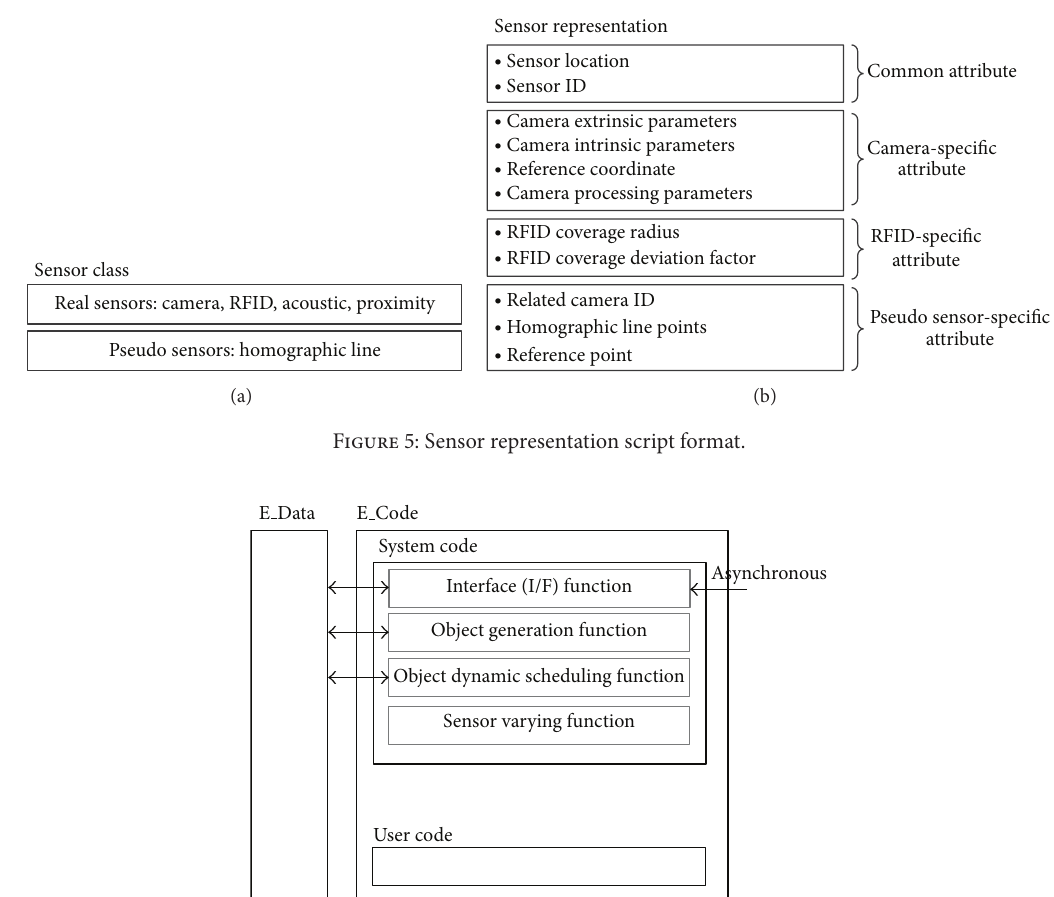
Figure 6: Interaction between environment and execution